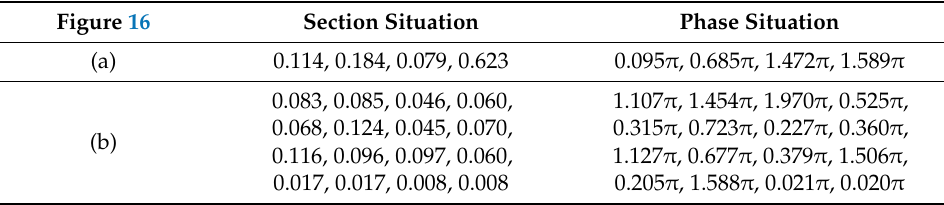
Table 8. Parameter settings of MPSM jamming with optimized section